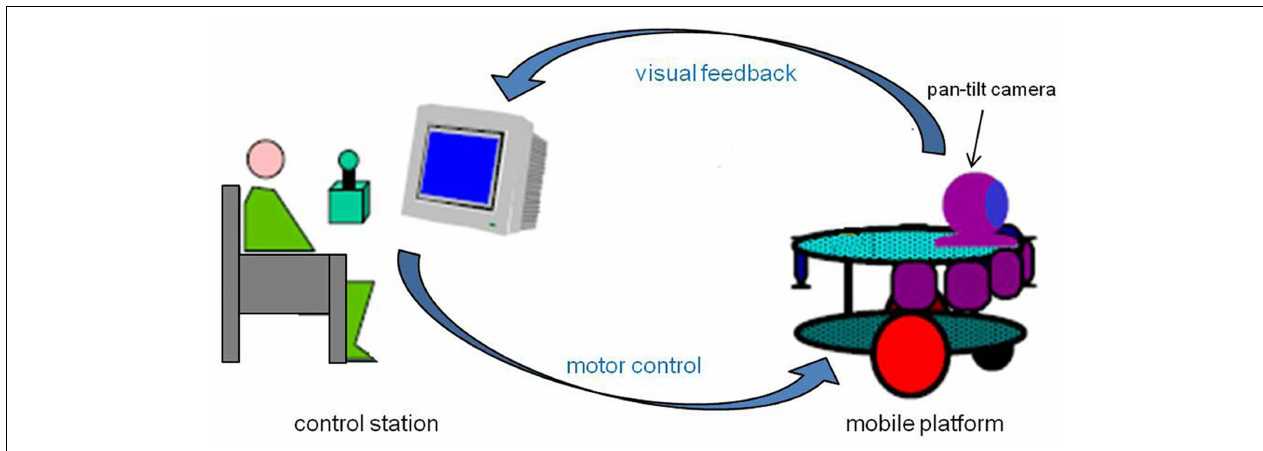
FIGURE 2 | Experimental configuration. The subject is seated at the control station from which s/he can remotely control the robotic device and receive a visual feedback from the pan-tilt camera embarked on the mobile platform.